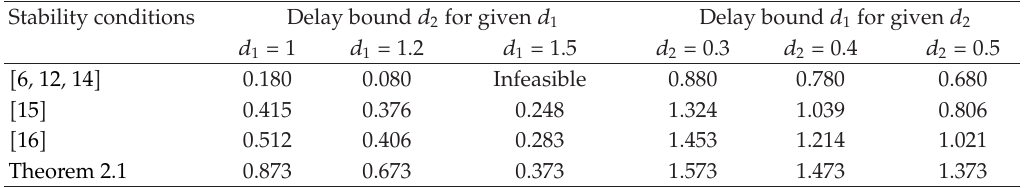
Table 1: Calculated delay bounds for di ff erent